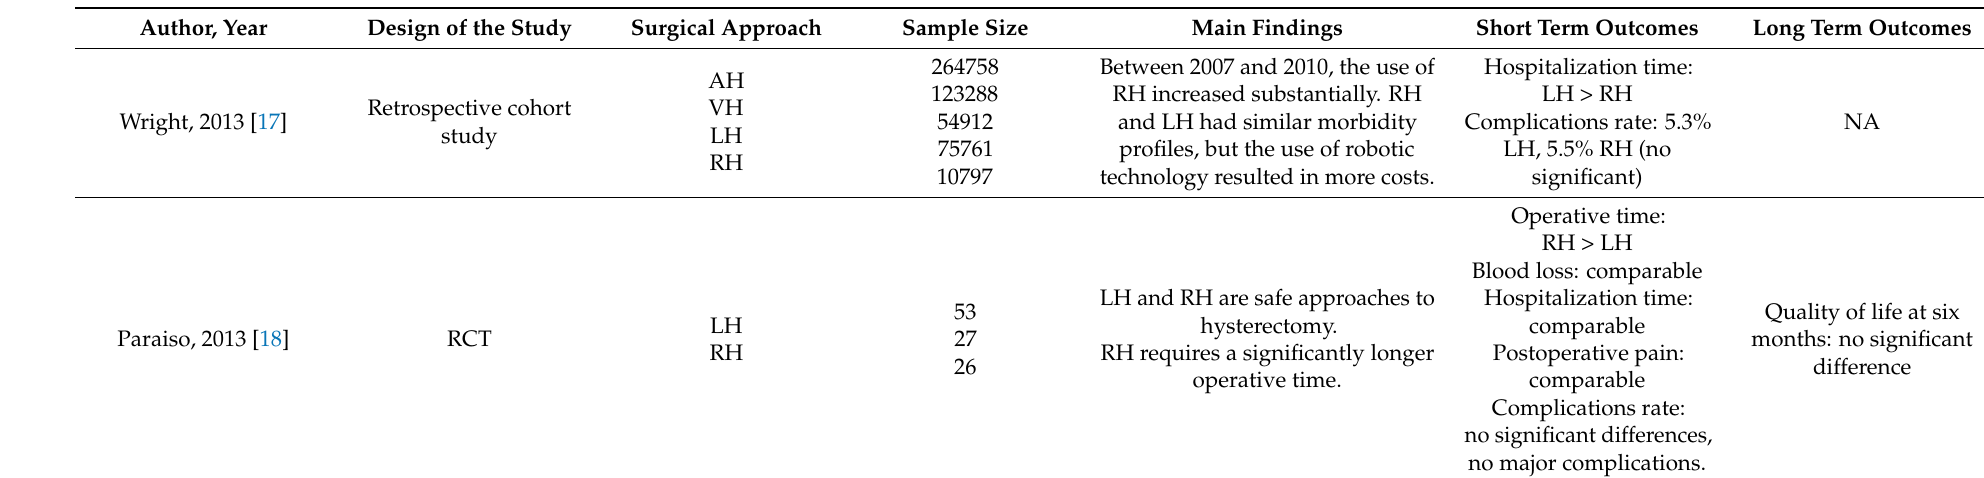
Table 2. Robotic Hysterectomy